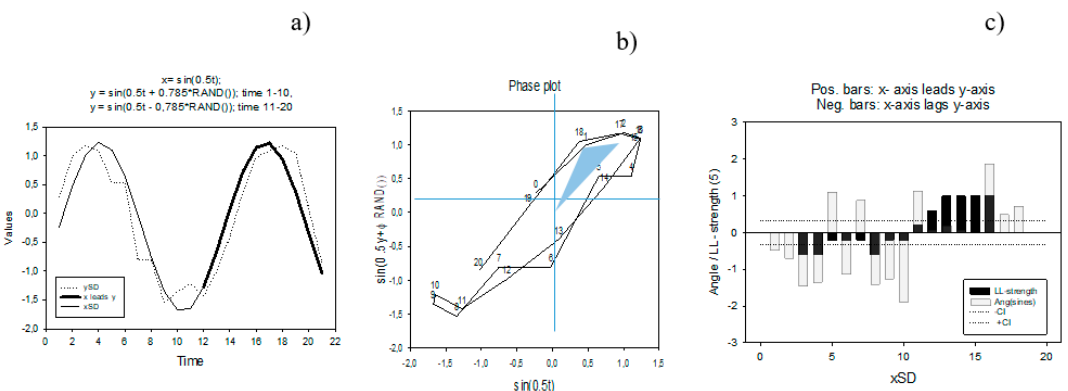
Figure 2. Example. Calculating leading-lagging (LL) relations and LL–strength. ( a ) Two sine functions: the smooth curve is a simple sine function, sin (0.5t), the dashed curve has the form sin (0.5t + φ × RAND()) where φ = +0.785 for t = 1–10 and φ = − 0.785 for t = 11–20. RAND() is the Excel random generator. Bold part of the simple sine function, xSd shows that it leads ySD. ( b ) In a phase plot with sin (0.5.t) on the x-axis and the sin(0.5t + φ × RAND()) on the y-axis, the time-series rotates first clock-wise (1 to 10, negative by definition) then counter clock wise 11 to 20; θ is the angle between two consecutive trajectories. The wedge suggests the angle between the origin and lines to observations 1 and 2. ( c ) Angles between successive trajectories (grey bars) and LL-strength (black bars). LL-strength allows some outliers from a persistent pattern. Dashed lines suggest confidence limits for persistent rotation in the phase plot and persistent leading or lagging relations in the time-series plot.